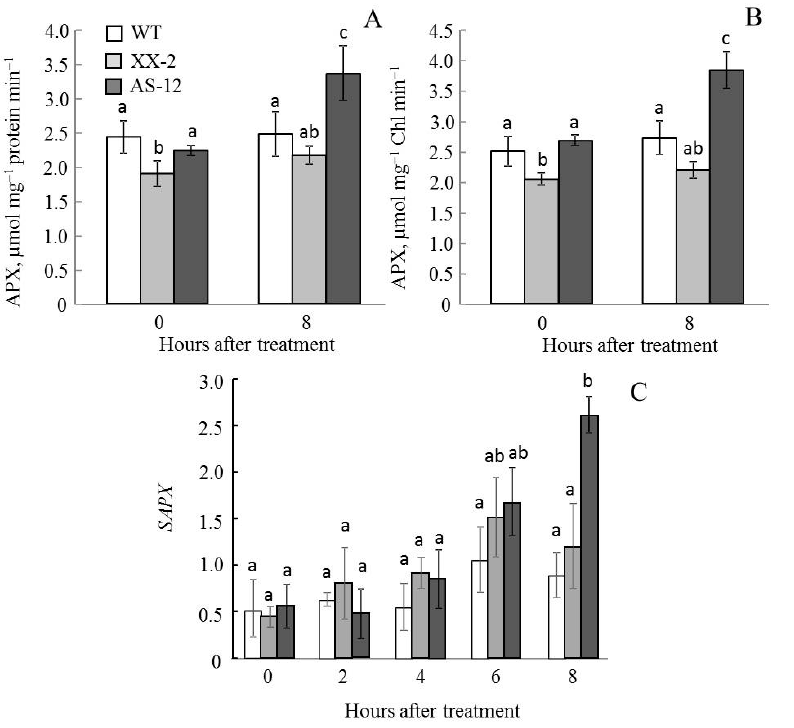
Figure 10. Ascorbate peroxidase (APX) activity in isolated chloroplasts per mg of chloroplast protein ( A ) and per mg of Chl ( B ), and expression of SAPX , encoding stromal APX ( C ), in leaves of WT, XX-2, and AS-12 Arabidopsis thaliana plants grown at 90 µ mol m − 2 s − 1 (0 h) and after 8 h of moderately high light (400 µ mol m − 2 s − 1 ). For SAPX expression values, the final number of expression values (ten) was used as n for statistical calculations. The transcript amounts are presented in relation to AT2G28390 and AT4G34270 housekeeping gene [23] expression values. Significant differences between mean values within each gene analysis are indicated by different letters (ANOVA, Duncan’s test, p < 0.05). For APX activity, data are presented as mean ± SE of values from three independent experiments (n = 3–6 for each experiment). Significant differences between mean values (ANOVA, Duncan’s test, p < 0.05) are indicated by different letters (a, b, c). The same or double letters (ab) indicate no significant differences between the means.